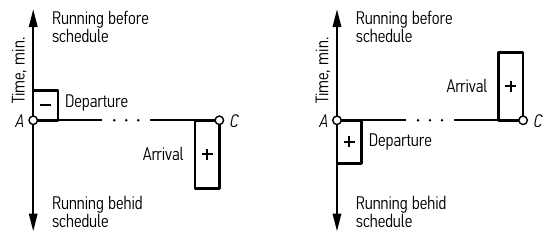
Fig. 2. The model of passenger train’s